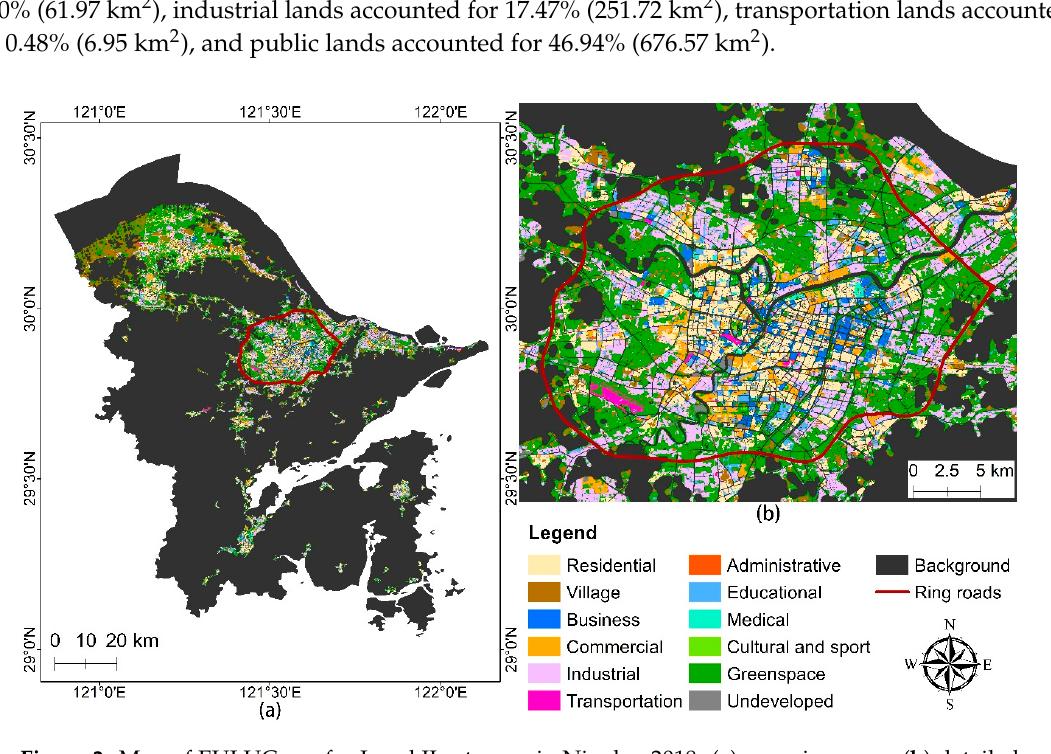
Figure 2. Map of EULUC-seg for Level II category in Ningbo, 2018: ( a ) overview map; ( b ) detailed zoomed-in view map of the central urban